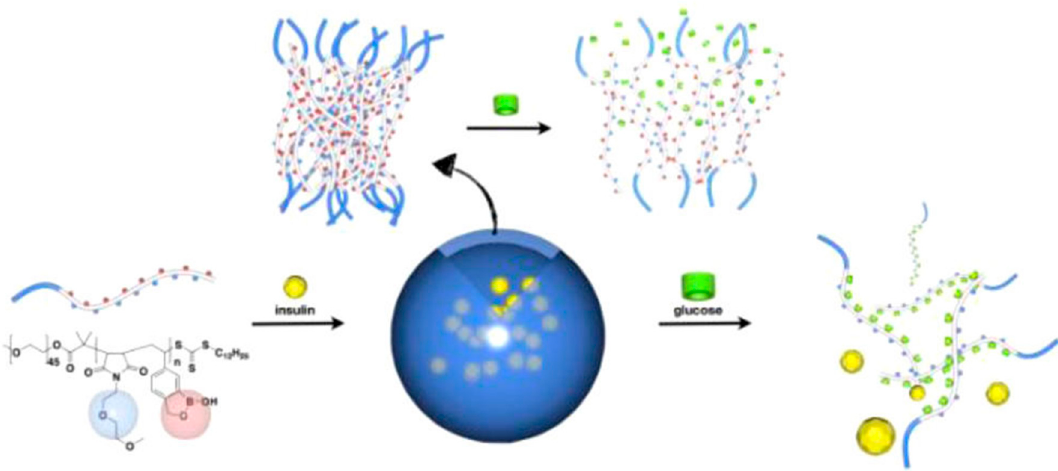
Figure 5. Schematic representation of glucose-triggered disassembly of polymersomes of sugar- responsive block copolymers [47]. Copyright 2012 American Chemical Society. responsive block copolymers [47]. Copyright 2012 American Chemical